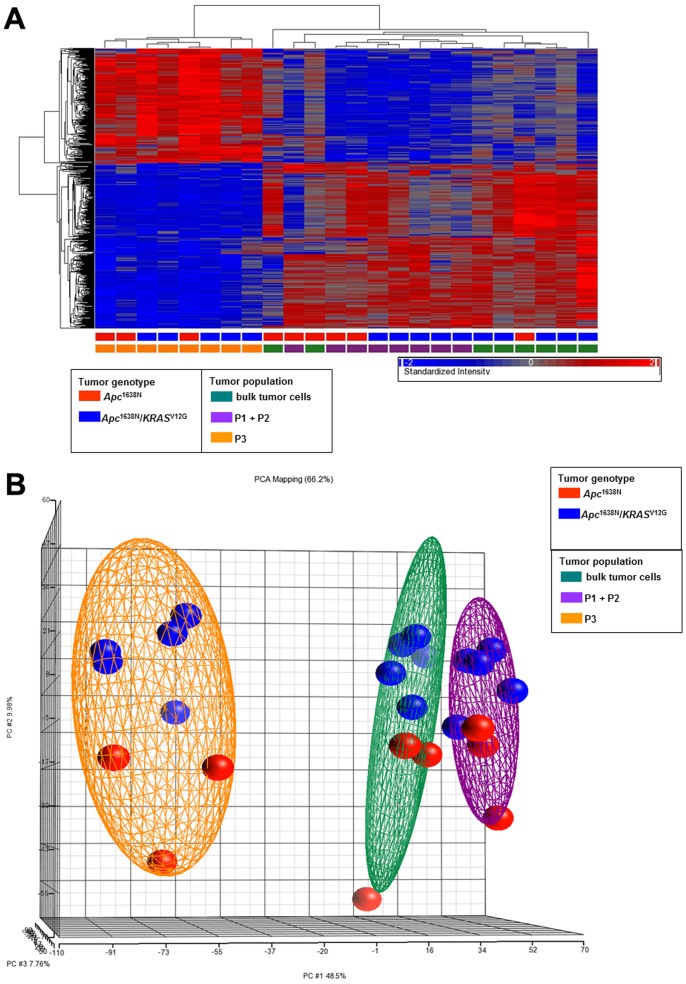
Expression profiling analysis of tumor cell subpopulations from Apc
1638N/+ and Apc
1638N/+/KRAS
V12G intestinal tumours.(a.) Hierarchical clustering and (b.) Principal Components Analysis (PCA) (both implemented in Partek) of Lin−CD24hiCD29+ (P3), Lin−CD24medCD29+/Lin−CD24loCD29+ (P1+P2, merged gate) and Lin− (bulk) tumor cells from 5 individual mice of each genotype (Apc
1638N/+ and Apc
1638N/+/KRAS
V12G). For better visualization individual colours were used for each group and in b. ellipsoids were drawn around the three tumour populations.